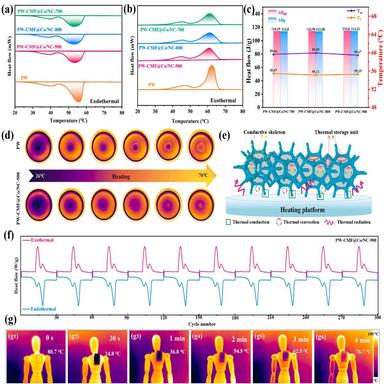
(a, b) DSC curves; (c) Phase change enthalpies and temperatures of PW and PW-CMF@Co/NC composite PCMs; (d) Infrared images of PW and PW-CMF@Co/ NC-900; (e) Schematic illustration of heat transfer mechanism; (f) DSC curves of PW-CMF@Co/NC-900 composite PCMs after different times thermal cycling; (g) IR thermal images of wood puppet placed oven at 100 ℃.